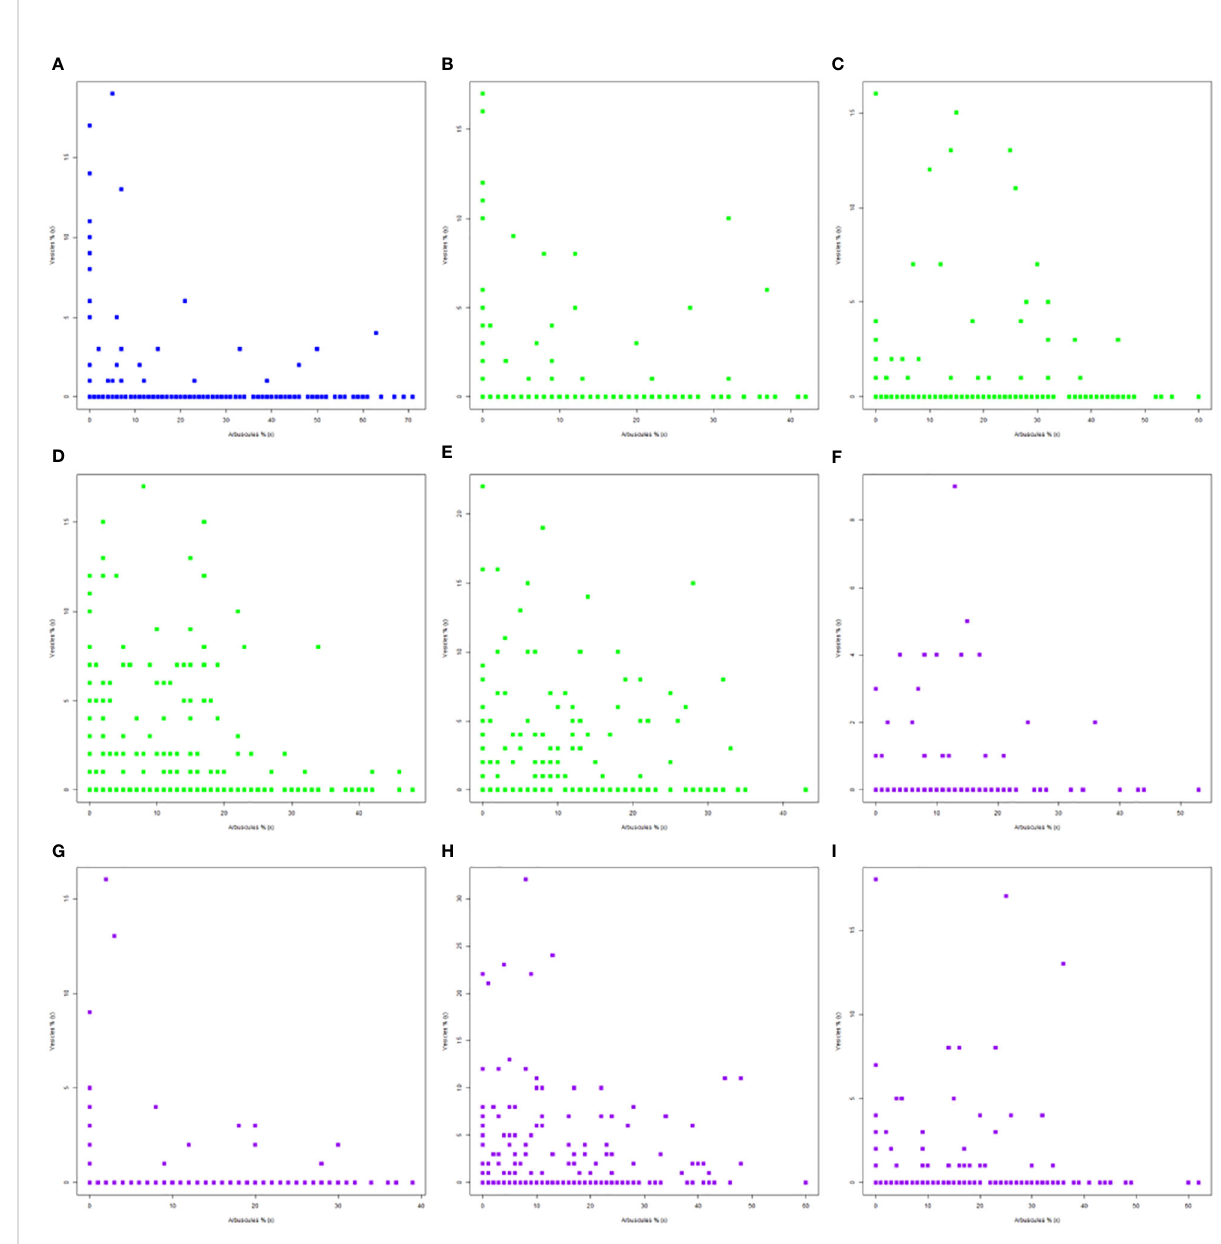
FIGURE 1 Simultaneous presence of arbuscules and vesicles in different phenophase under the in fl uence of applied biostimulator: (A) A0-B1, (B) A1-B2, (C) A1-B3, (D) A1-B4, (E) A1-B5, (F) A2-B2, (G) A2-B3, (H) A2-B4, and (I) A2-B5. Legend: A0-B1, control variant (native mycorrhizal pro fi le) in phenophase 2 – 4 leaves; A1, untreated plants; A2, treated plants; B2, phenophase of 6 formed leaves; B3, phenophase of 8 – 10 formed leaves; B4, cob formation phenophase; B5, phenophase corresponding to physiological